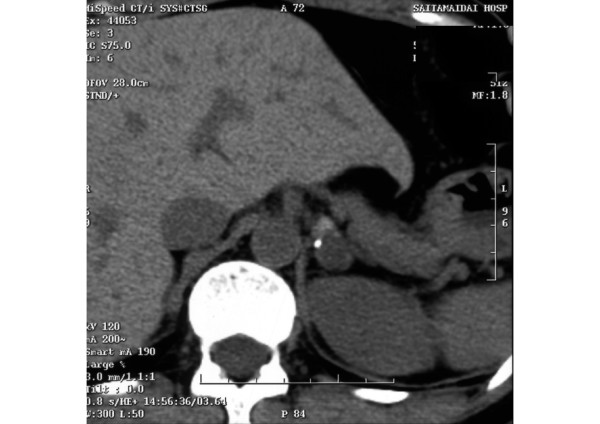
CT shows a 16 × 10 mm left adrenal mass.